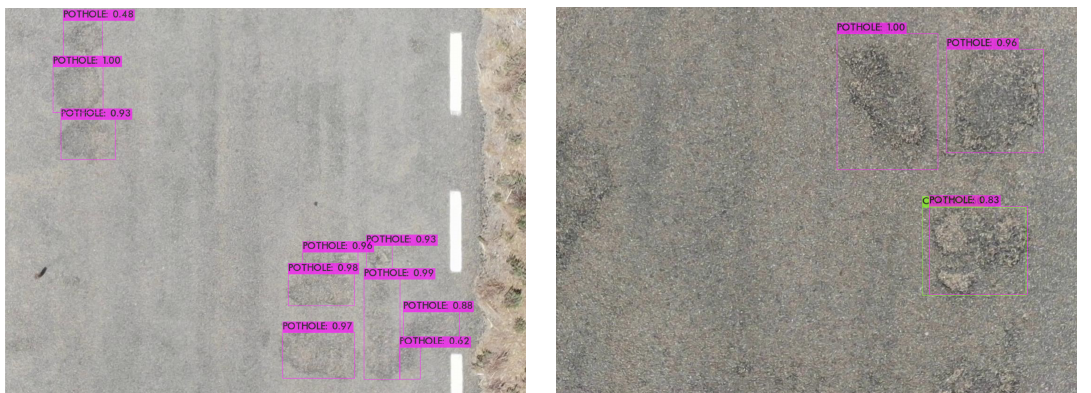
Figure A3. Detection